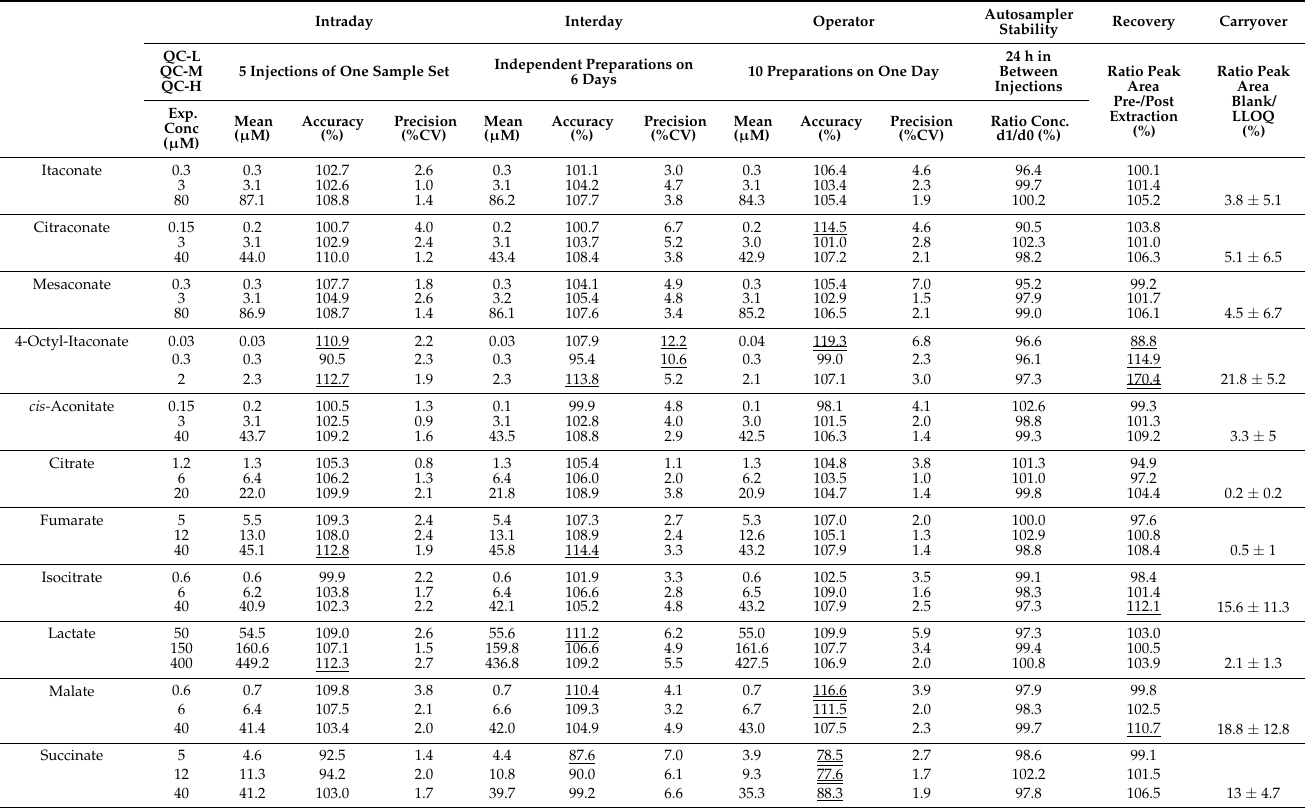
Table 1. Results of basic